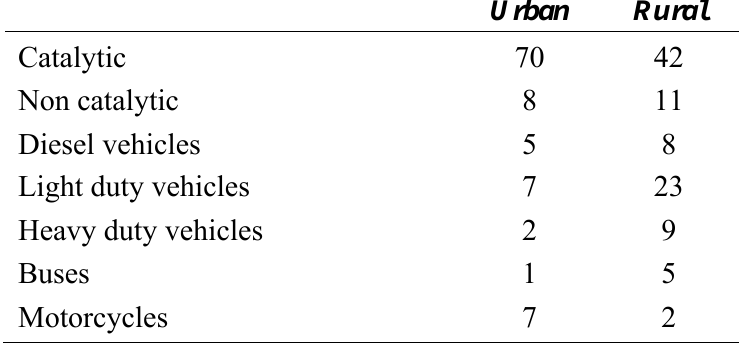
Table 1 . Percentage distribution of vehicle categories in each studied